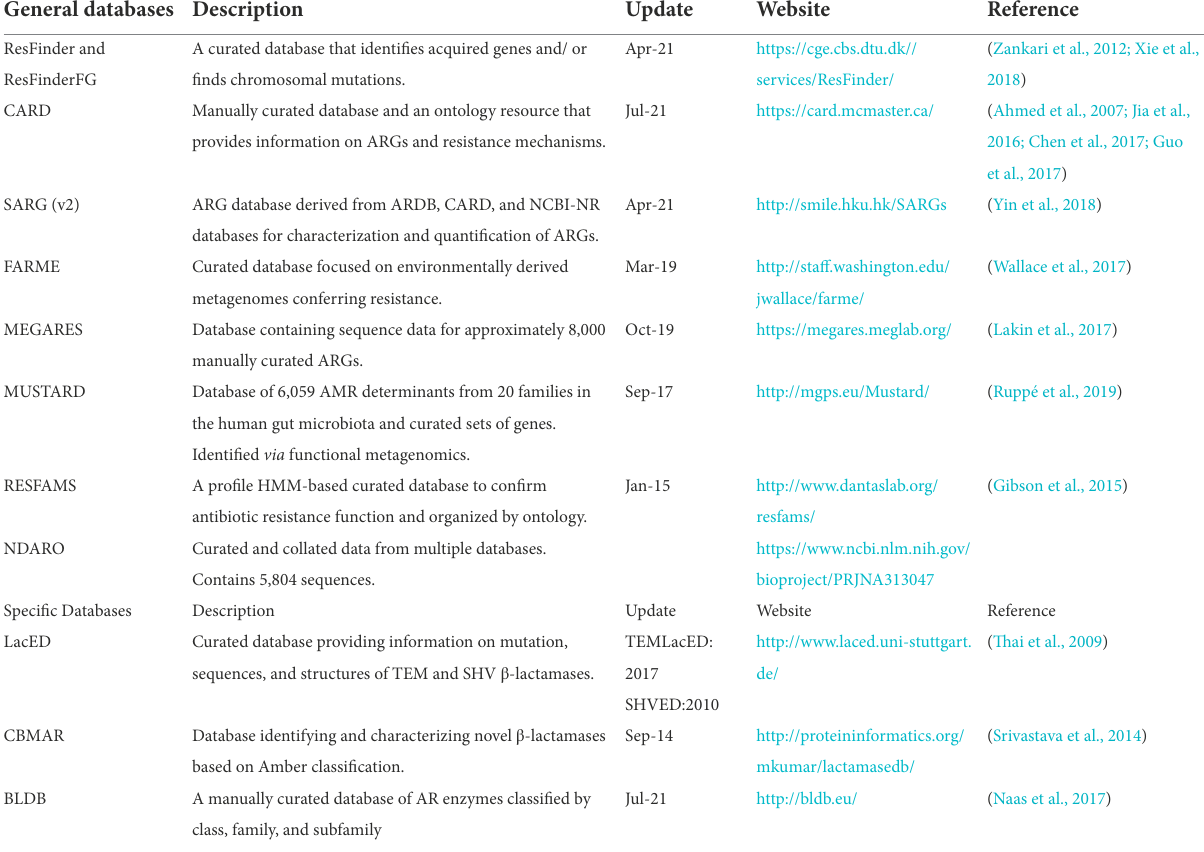
TABLE 3 General and specific databases in AMR research. General databases